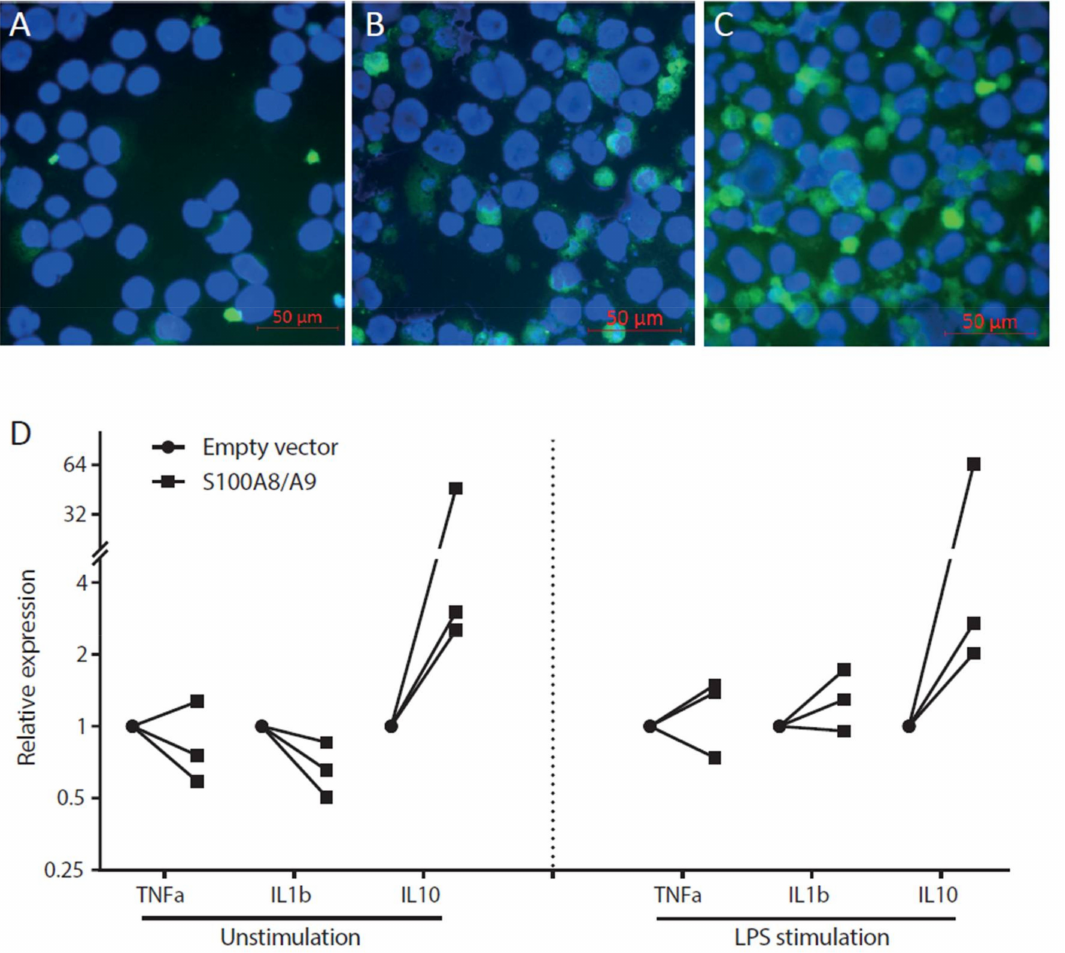
Figure 5. Overexpression of S100A8/A9 in macrophages leads to increased IL-10 expression. ( A – C ) Validation of transfection efficiency of the THP-1 macrophage cell line. The following cytospins were inspected by immunofluorescence for green light emission: ( A ) non-transfected cells; ( B ) cells transfected with an empty plasmid; ( C ) and those with a GFP-containing plasmid. Scale bar: 50 µ m. The results show high transfection efficiency in the cells; ( D ) Overexpression of S100A8 and S100A9 leads to a consistent increase of IL-10 expression, but not of TNF α and IL-1 β . This was observed in both unstimulated cells ( left panel) and LPS–stimulated cells ( right panel). Data are shown as boxplots (median, upper value, lower value) representing three different